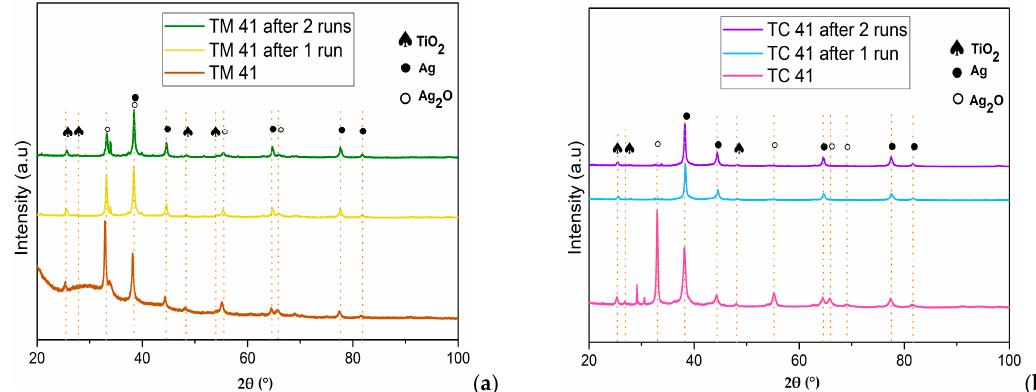
Figure 8. XRD patterns of ( a ) TM 41 and ( b ) TC 41 after two cycles of MB bleaching employing UV/vis light.